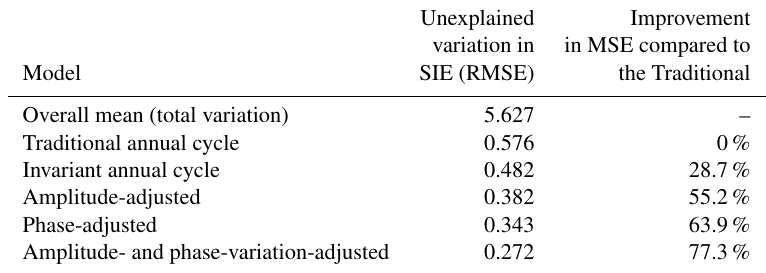
Table 1. Comparison of the various proposed annual cycles in terms of how well they explain the variation in daily SIE. Values are given as percentages of mean-squared error and the root-mean-squared error